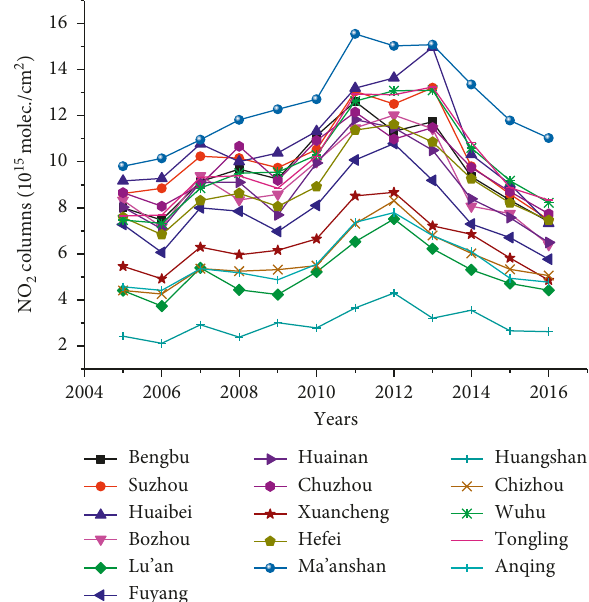
Figure 11: The average tropospheric NO Anhui from 2005 to